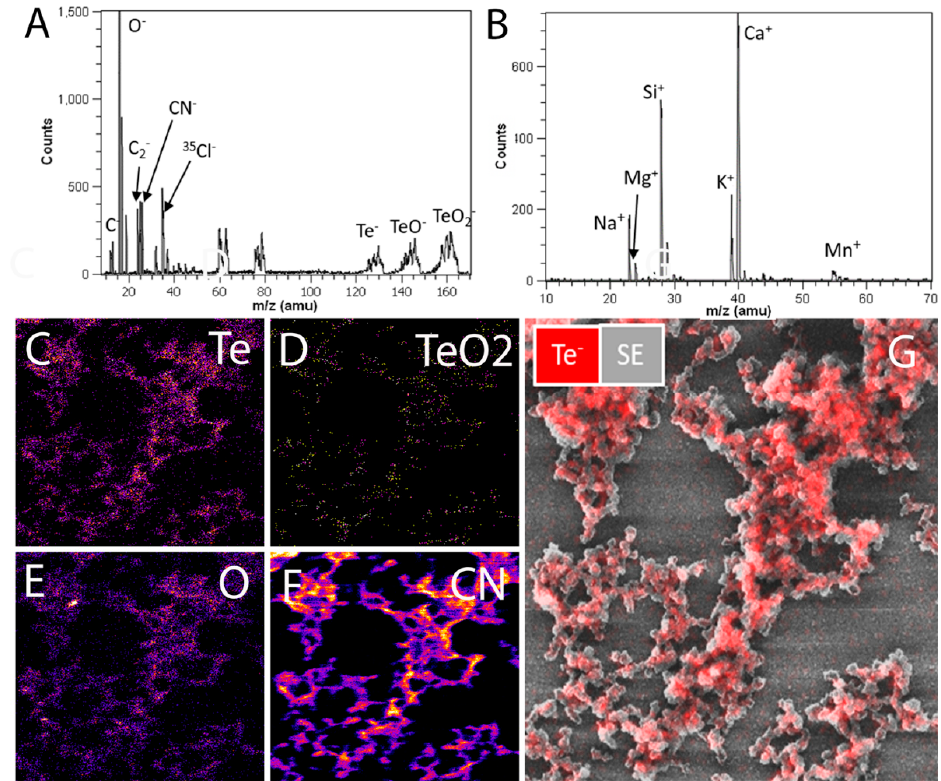
Figure A7. Secondary ions mass spectra acquired from a 50 µm × 50 µm field of view with a 20 keV energy neon ion beam: ( A ) positive mode and ( B ) negative mode; 4 µm × 4 µm field of view SIMS images of aggregated AV-TeNPs: SIMS images of Te, TeO 2 , O. and CN negative secondary ions acquired simultaneously with a 4 pA current neon beam at 20 keV of energy ( C – F ) and an overlay of the co-registered in situ SE (gray) and Te ions (red) images ( G ).